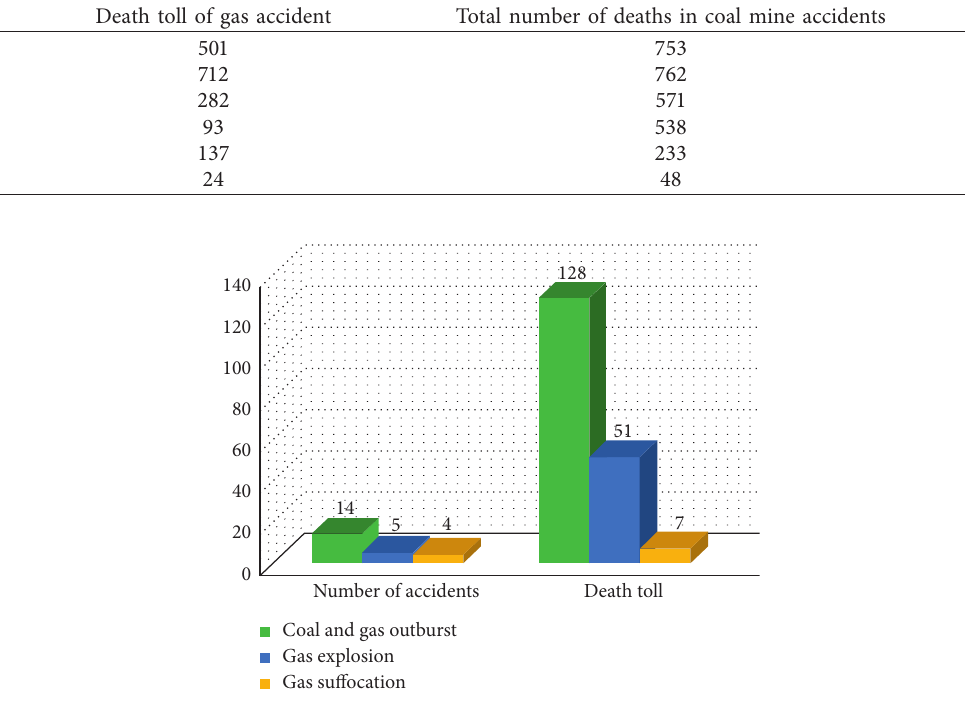
Figure 3: Coal mine accidents and deaths from gas outburst, gas explosion, and gas suffocation in LPS for